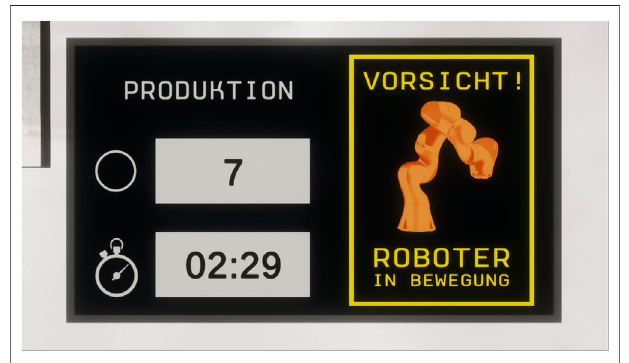
FIGURE 7 | Additional noti fi cations complemented the communication channels, informing the participant about the current activity status of the robot arm ( “ Caution! Robot in motion ” ). The left side of the display contained informationaboutthesharedtaskbyshowingtheremainingtimeandthe production quantity to the